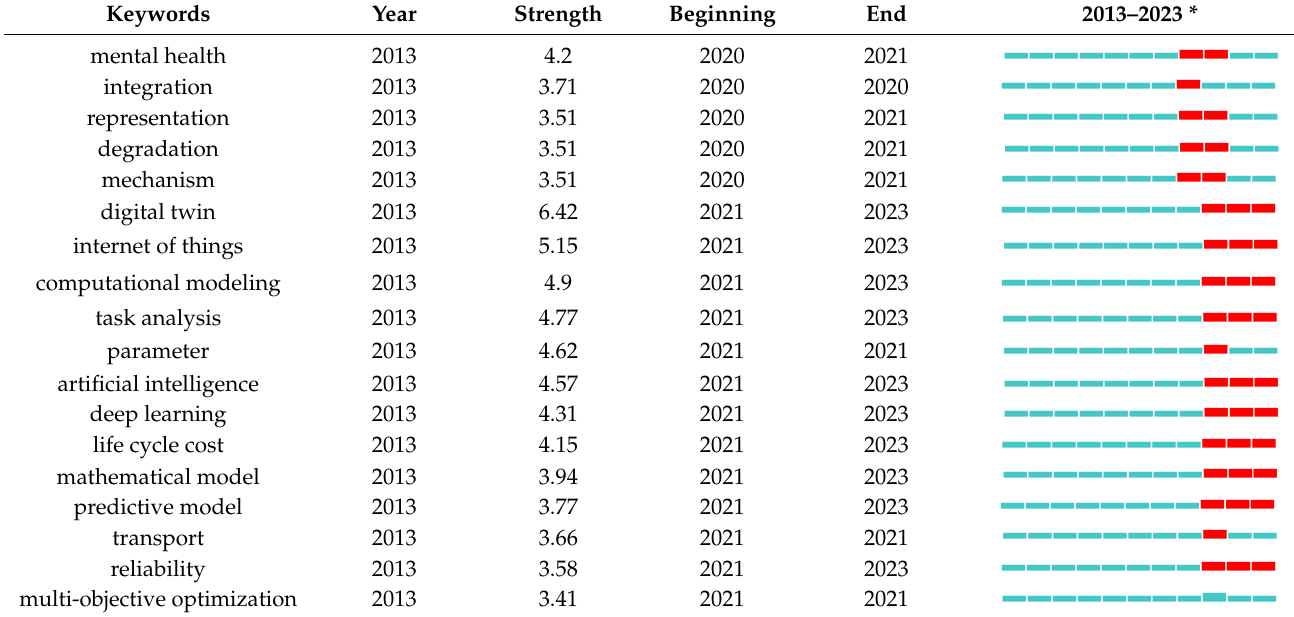
* The red color represent the hot period of each keyword during 2013 –